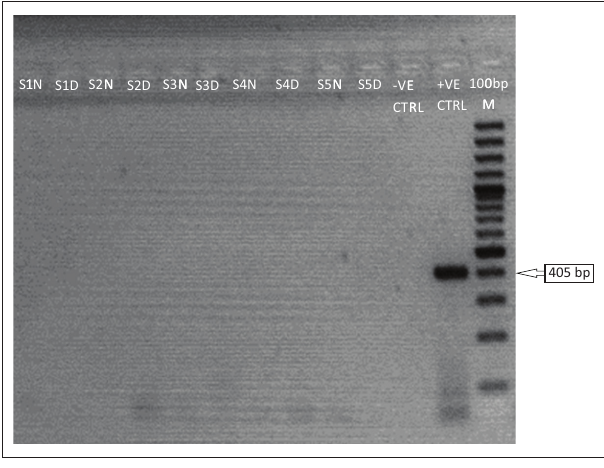
FIGURE 3: Reverse transcription polymerase chain reaction detection of the yellow fever virus, Lagos, Nigeria, March 2018. The gel lanes represent neat (undiluted, N) and 1:10 dilutions (D) of the RNA extracts used. Three Nigerian outbreak samples representing lanes S1–S3 (accession numbers: MF317933-35) were run alongside Benin Republic outbreak samples (S4–S5). RNase/DNase free water was used as a negative extraction control (-VE CTRL) while a tissue culture inactivated sample